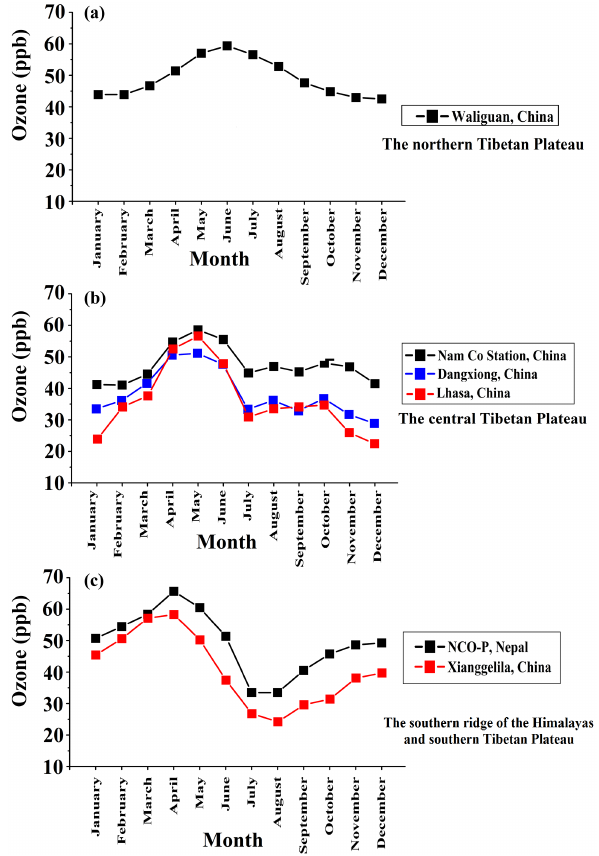
Figure 9. Monthly variation in surface ozone at different sites in the Tibetan Plateau ( a : the northern Tibetan Plateau – summer- maximum type; b : the central Tibetan Plateau – spring-maximum type; c : the southern Tibetan Plateau and the southern ridge of the Himalayas – spring-maximum type) (based on Ma et al., 2014; Lin et al., 2015; Ran et al., 2014; Cristofanelli et al., 2010; Zhu et al.,